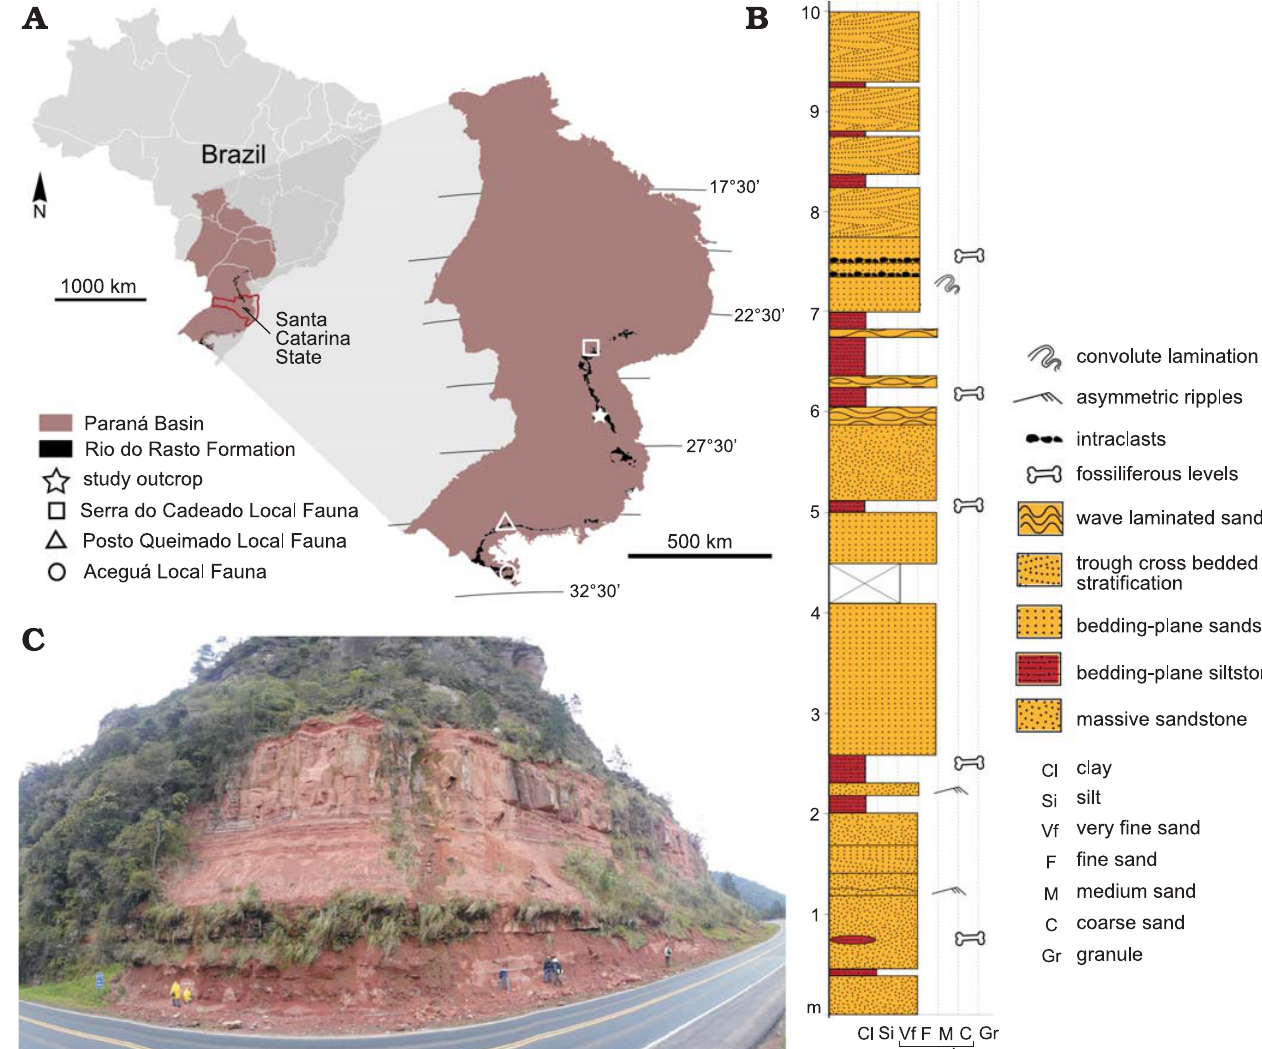
Fig. 1. A . Geographic map with the location of the study outcrop in Santa Catarina State within Paraná Basin, Brazil. B . Profile of the study outcrop with fossiliferous levels. C . Photo of the